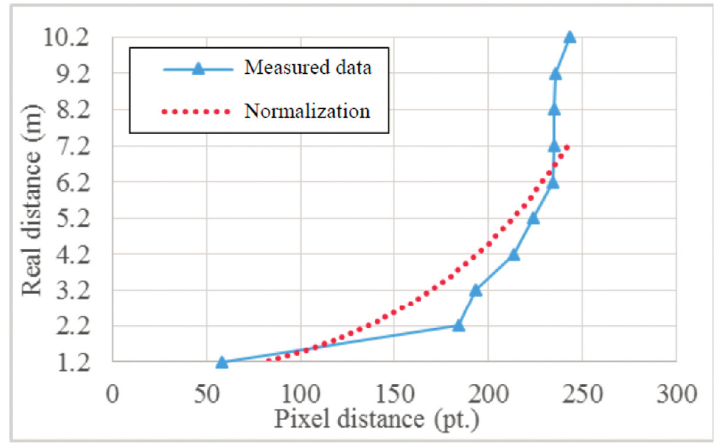
Figure 4. Function for converting pixel distance to real